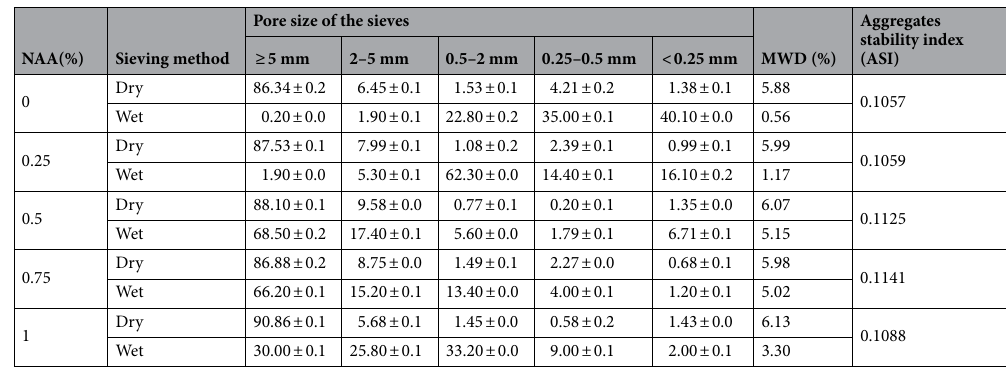
Table 3. Particle size distribution of soil aggregates. Average value ± standard